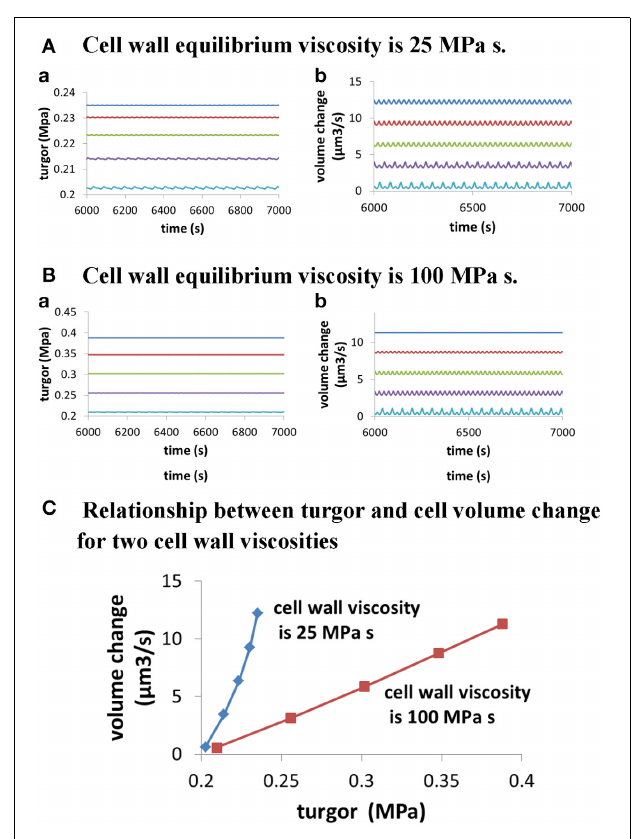
FIGURE 3 | Dependence of cellular turgor and volume change of pollen tube on osmolarity in the media for two cell wall viscosities. In both (A,B) , osmolarity in the media increases from 0.06 to 0.46 Osm by increasing 0.1 Osm each time from top to bottom. When osmolarity increases in the media, cellular turgor decreases. (A) Dependence of cellular turgor and volume change of pollen tube for osmolarity in the media for low cell wall viscosity (25MPa s) (i.e., large cell wall extensibility). (B) Dependence of cellular turgor and volume change of pollen tube on osmolarity in the media for high cell wall viscosity (100MPa s). (C) Dependence of volume change of pollen tube on turgor for two cell wall